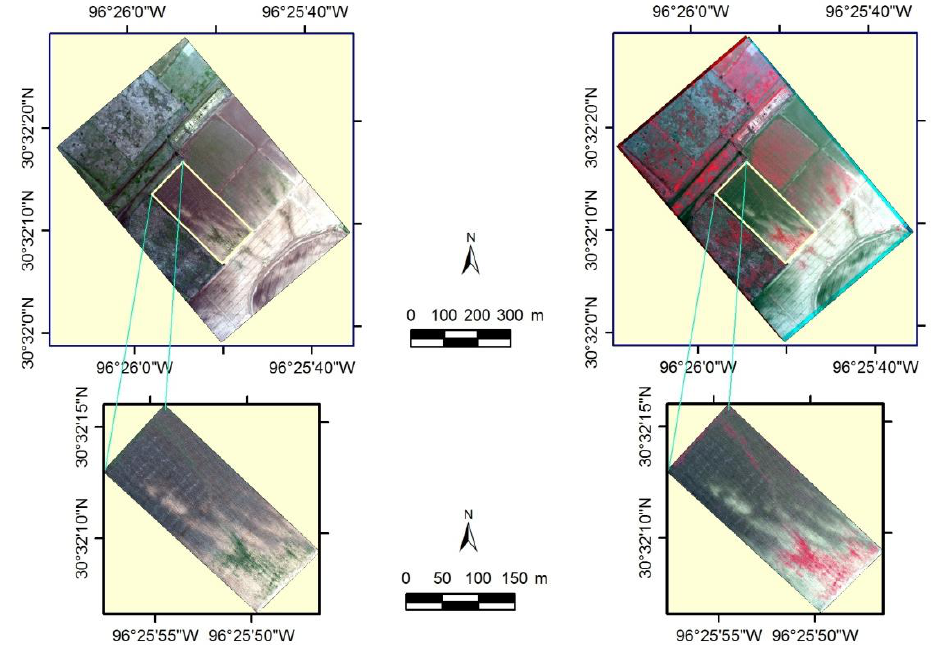
Figure 9. Normal color ( left ) and color-infrared ( right ) images acquired at 457 m (1500 ft) above ground from a fallow field infested with henbit near College Station, Texas on 13 February 2013.